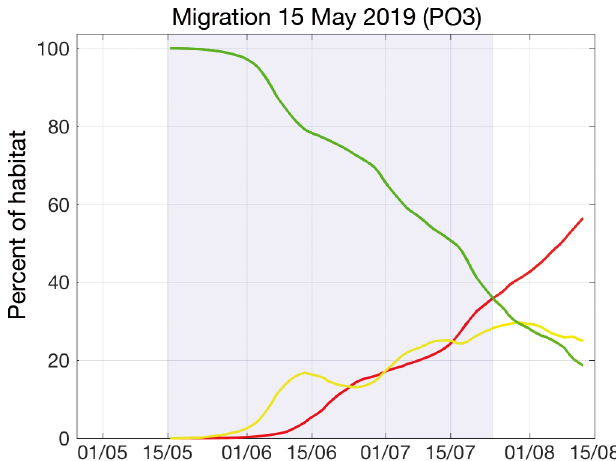
Fig. 2. Estimated percent of total marine living area in PO3 where sea trout smolt are likely to be infested with >18 mo- bile lice (red line), between 6 and 18 mobile lice (yellow line) and <6 mobile lice (green). The blue shaded area indicates a period of 70 d starting on an intermediate migration date (May 15), the same period shown in Fig. 1